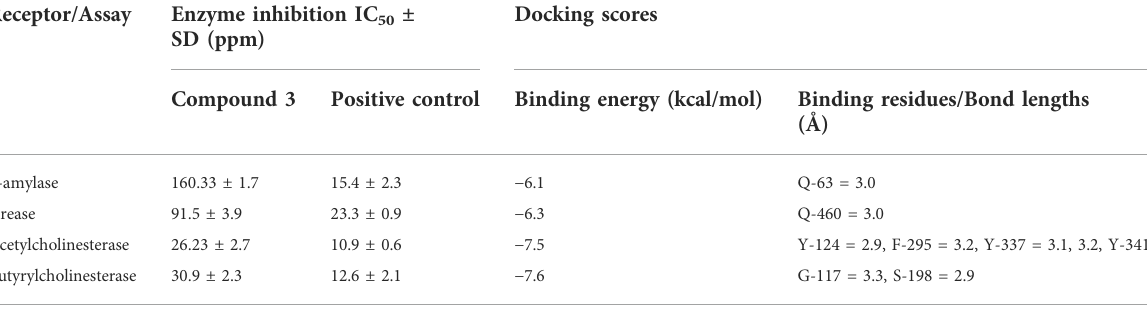
TABLE 1 Enzyme inhibition assay and Molecular docking